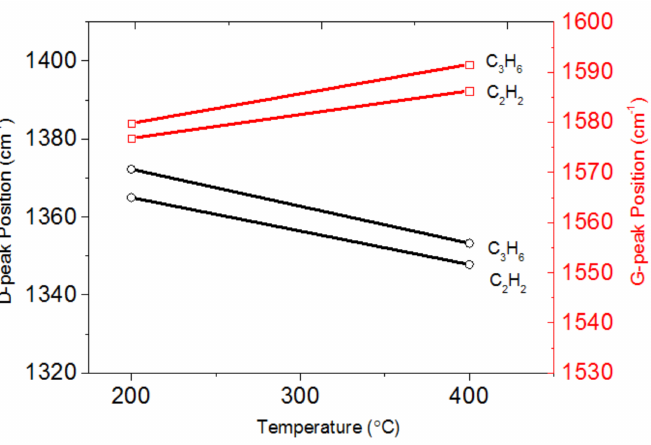
Figure 4. Raman shift for D-peak and G-peak positiion with carbon source of C 3 H 6 and C 2 H 2